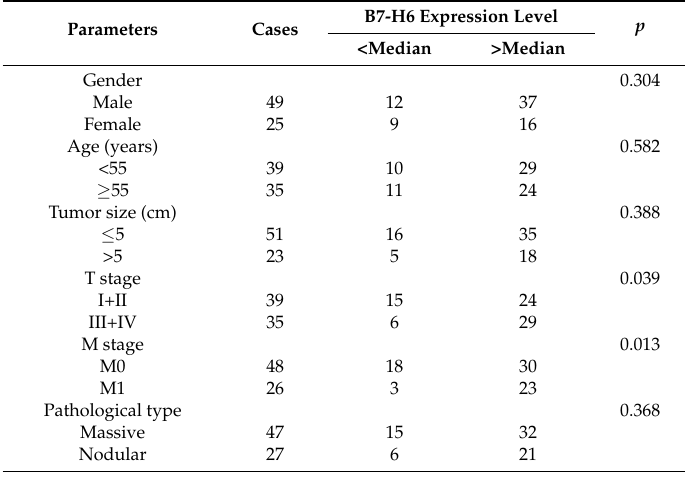
Figure 5. B7-H6 overexpression and its correlation with clinical parameters in HCC. ( A ) Detection of B7-H6 mRNA levels of in HCC (T) and adjacent non-tumor liver tissues (N) using real-time PCR. *** p < 0.001, Student’s t -test. ( B ) Detection of B7-H6 protein expression levels in HCC (T) and adjacent non-tumor liver tissues (N) using Western Blot. β -actin was used as control. ( C ) Cellular localization of B7-H6 using immunohistochemistry (IHC). Relatively negative, weak, moderate and strong staining images compared with normal tissues are shown. ( D ) The probability of overall survival (OS) was significantly different in B7-H6 low expression group and B7-H6 high expression group of the 74 patients ( p < 0.05). Table 1. Correlation between B7 ‐ H6 expression and clinical parameters in HCC